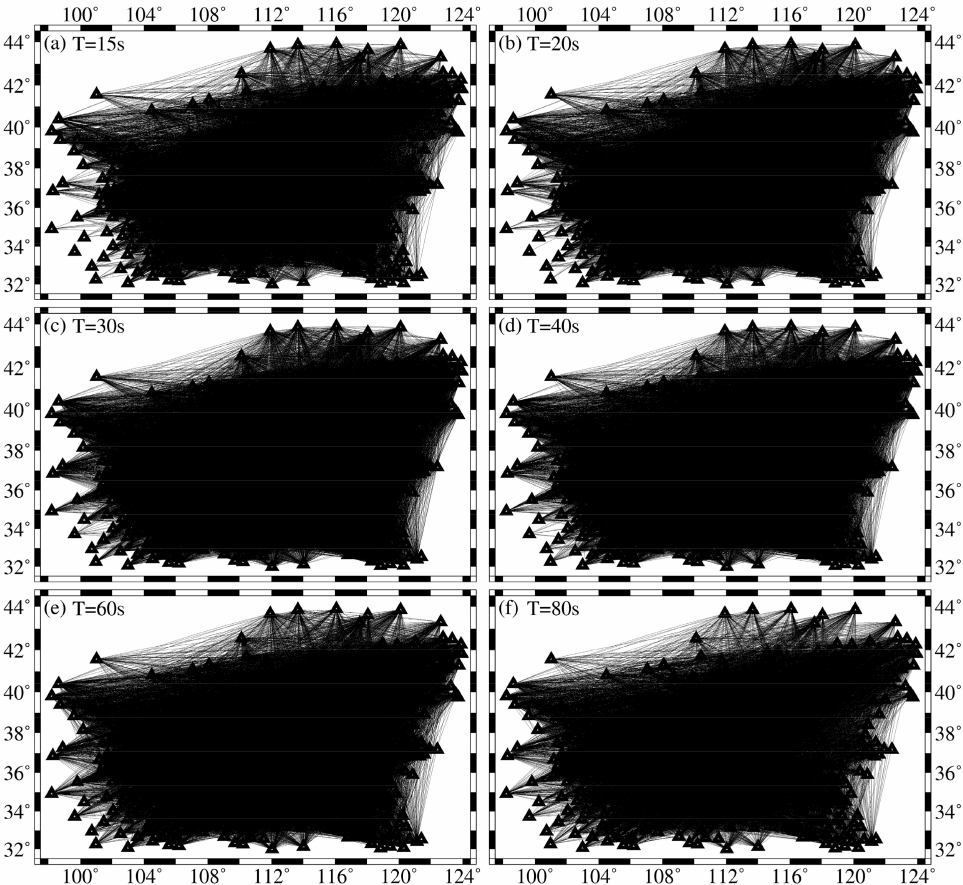
Figure 5. Path coverage for Rayleigh wave phase velocity at periods of ( a ) 15, ( b ) 20, ( c ) 30, ( d ) 40, ( e ) 60, and ( f ) 80 s,